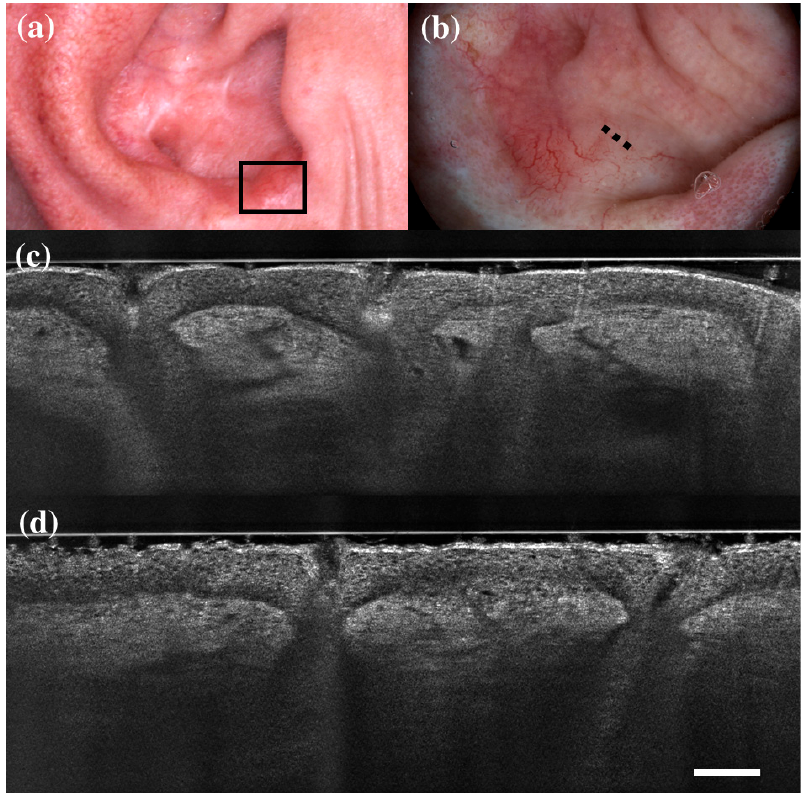
Figure 2. False positive case of basal cell carcinoma at dermoscopy. Clinical ( a ), dermoscopic ( b ), and LC-OCT images ( c , d ). Dermoscopy identified the lesion as a basal cell carcinoma, while LC- OCT identified it as healthy skin. Histology confirmed the diagnosis of healthy skin. Dashed line ( b ) indicates the approximate area of the LC-OCT imaging. White scale bar in LC-OCT images: 100 µ m.